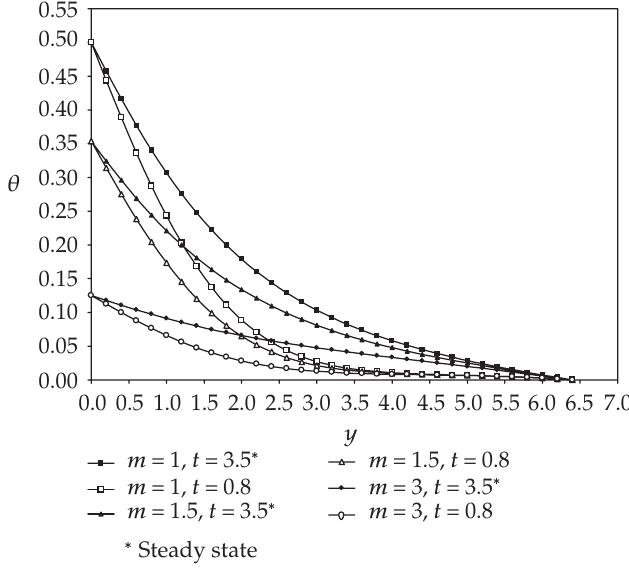
Figure 5.6 . Transient temperature profiles for the di ff erent values of m and for the values x = 0 . 5, F = 0 . 01, M = 1, and Pr = 0 . 7.